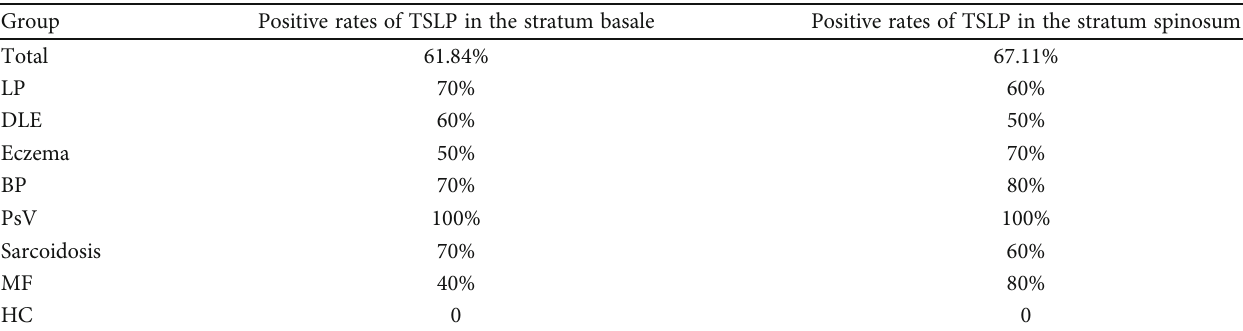
Table 3: Positive rates of thymic stromal lymphopoietin expression in the epidermis in each group. Group Positive rates of TSLP in the stratum basale Positive rates of TSLP in the stratum